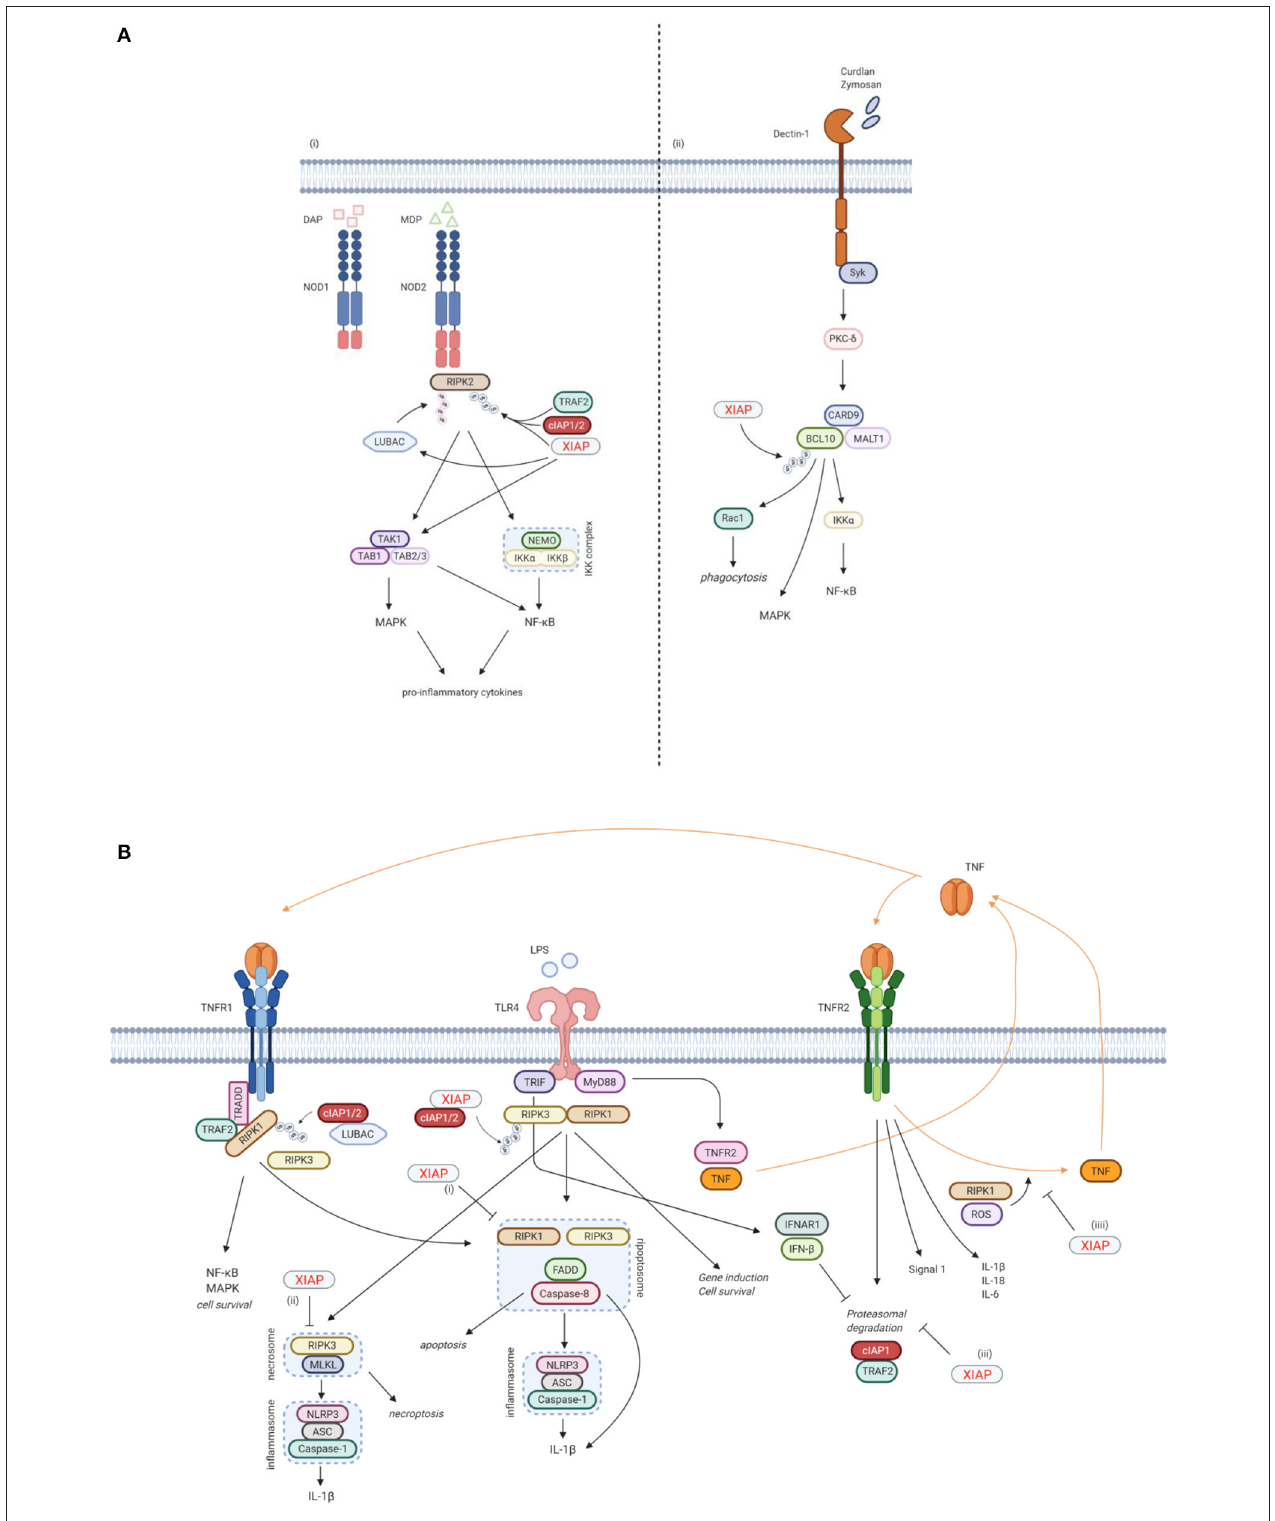
FIGURE 3 | XIAP plays a key function in various immune pathways. (A) XIAP is required for pattern recognition receptors (PPR) mediated innate immune responses. (i) XIAP is essential for the NOD1/2 induced activation of the NF- κ B and MAPK pathways and secretion of pro-inflammatory cytokines and chemokines (40). NOD1